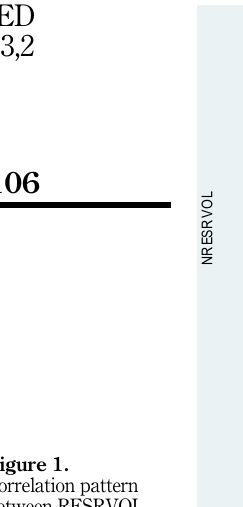
Figure 1. Correlation pattern between RESRVOL and